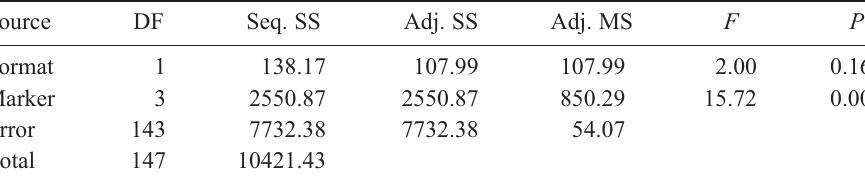
Table 2. Analysis of covariance.